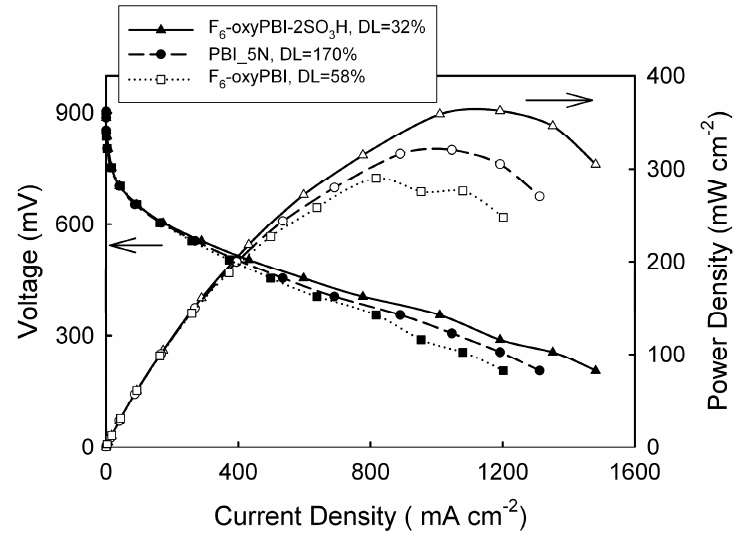
Figure 1. Polarization curves of MEAs based on fluoro- and sulfonated fluoro-oxyPBI membranes at 150 °C and without any external humidification. The data of PBI_5N are shown for comparison. DL: doping level (taken from Ref. [21]). DL is given by the relationship.